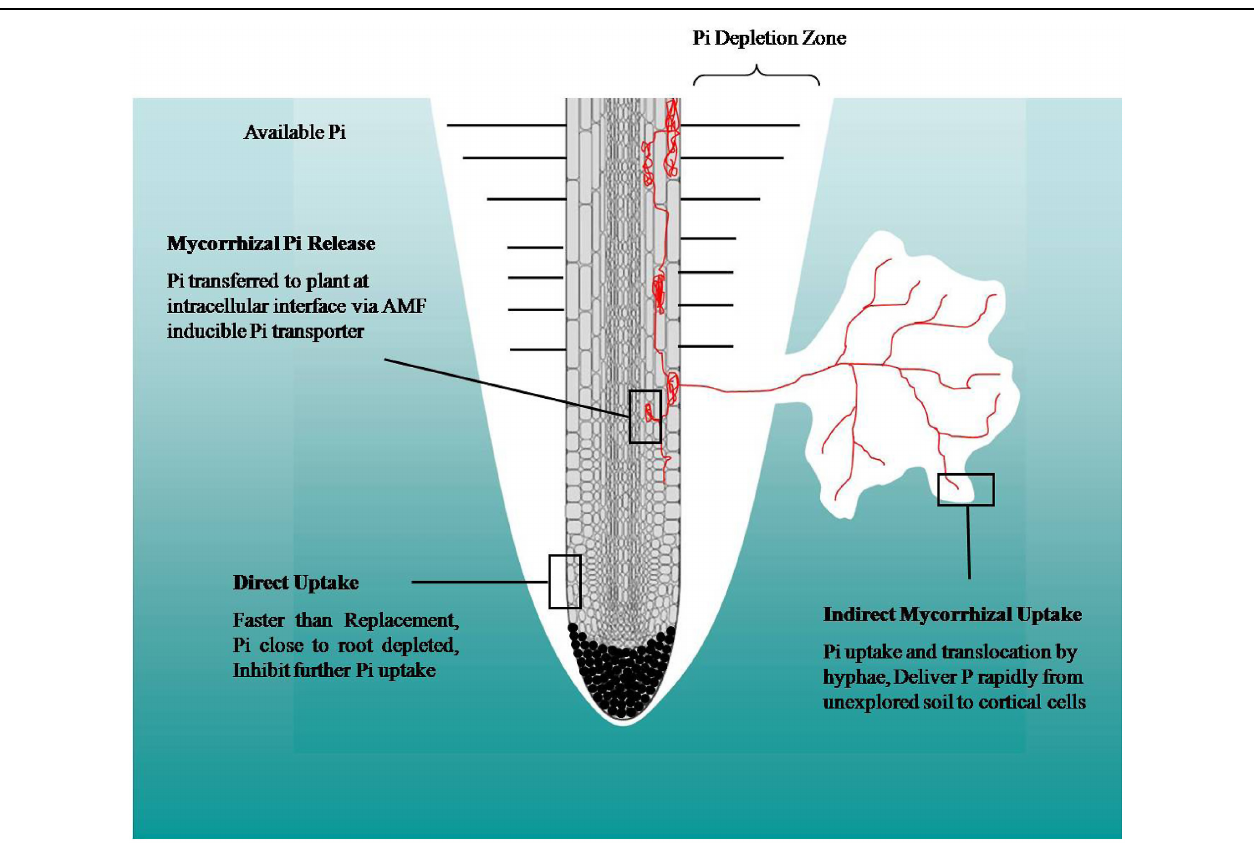
FIGURE 1 | Uptake of phosphorus by plants from soil. Two modes of P uptake are present in plants. (A) Direct uptake – between soil and plant root and (B) indirect uptake – through mycorrhizal symbiosis, where AM fungus extra-radical mycelium acquire Pi beyond rhizosphere and Pi transported to intra-radical mycelium as poly-phosphate (Rosewarne et al.,